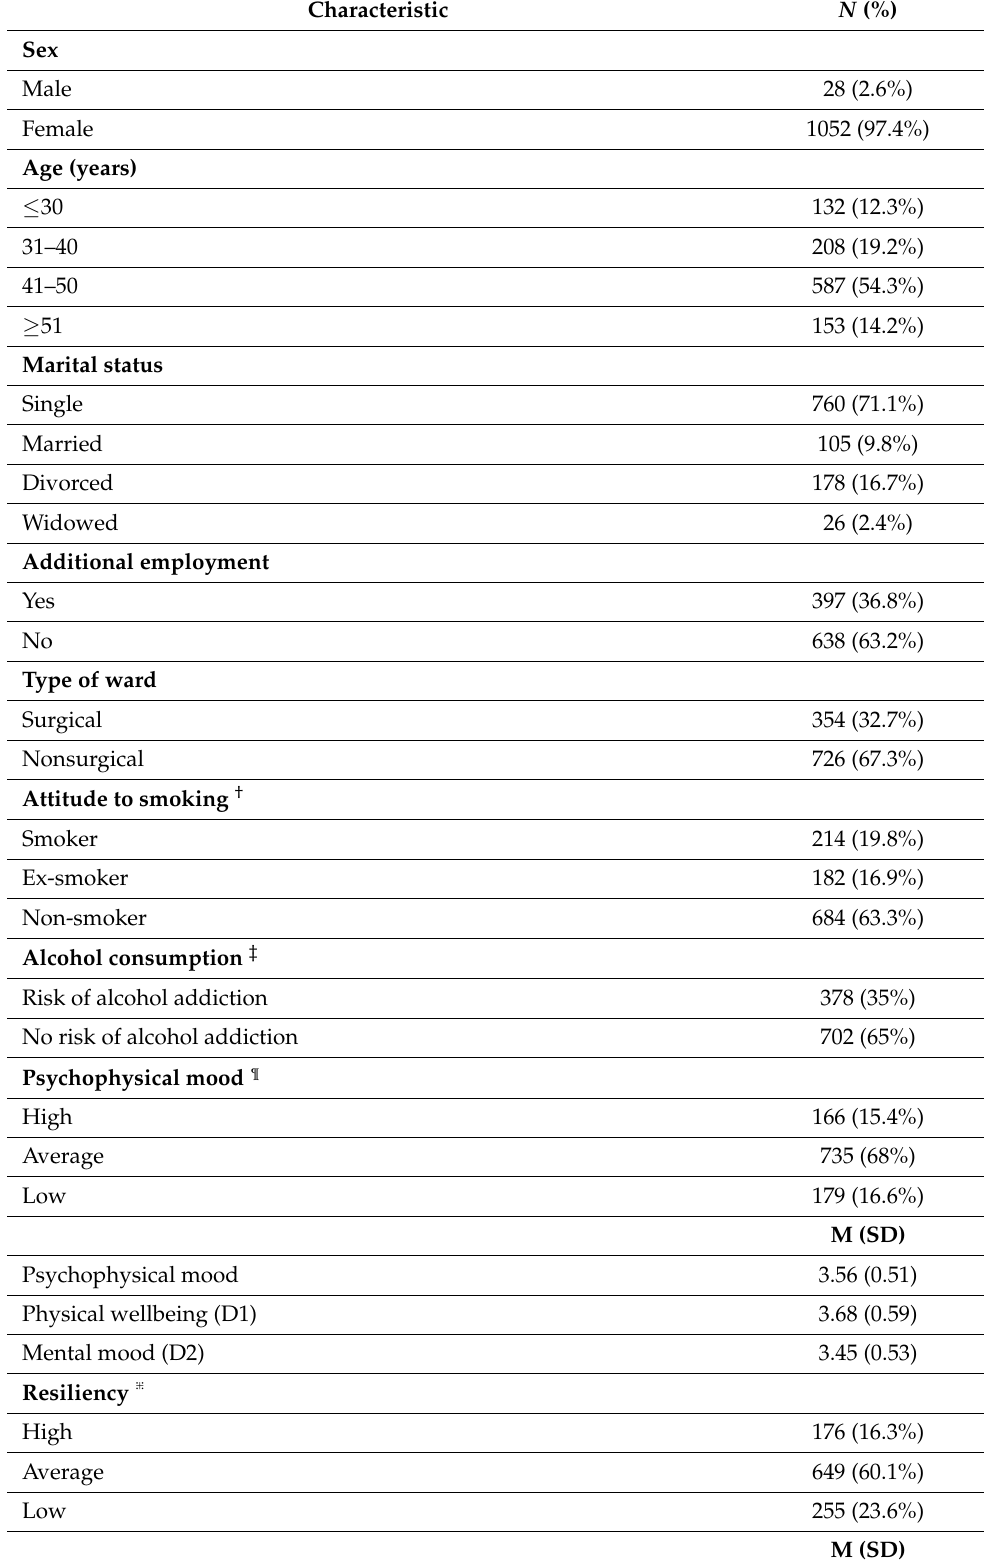
Table 1. General characteristics of the analysed group of nurses in Poland. Characteristic